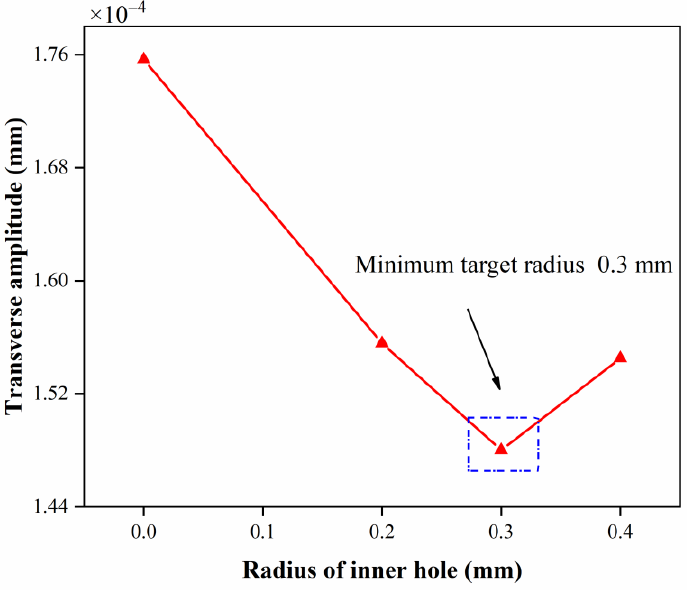
Figure 15. Transverse amplitudes with different radii of inner